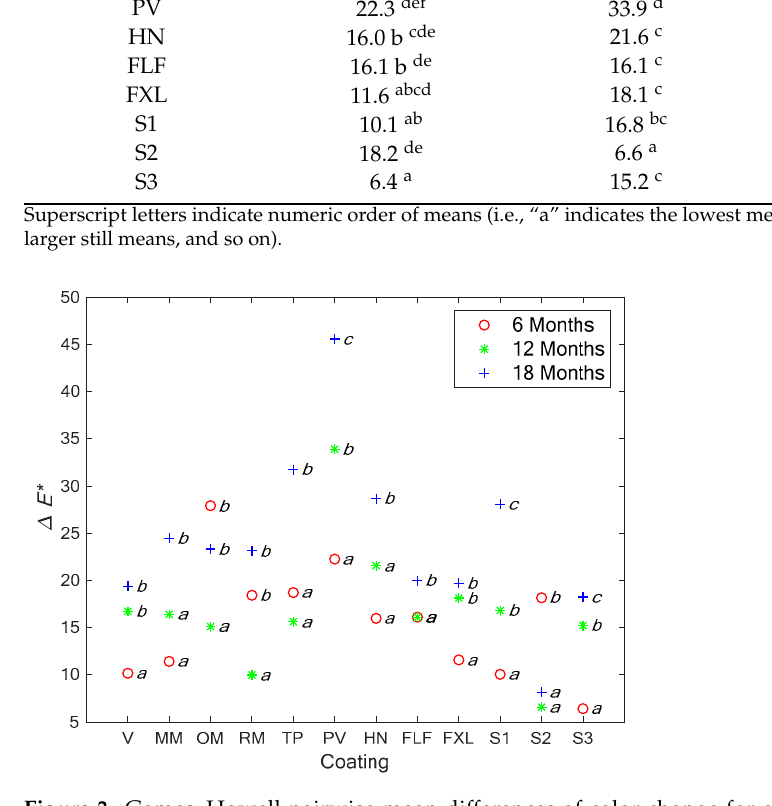
Figure 3. Games–Howell pairwise mean differences of color change for each coating during the study for Douglas-fir. Superscripts with the same letter indicate means between intervals that are not significantly different at the p < 0.05 level.